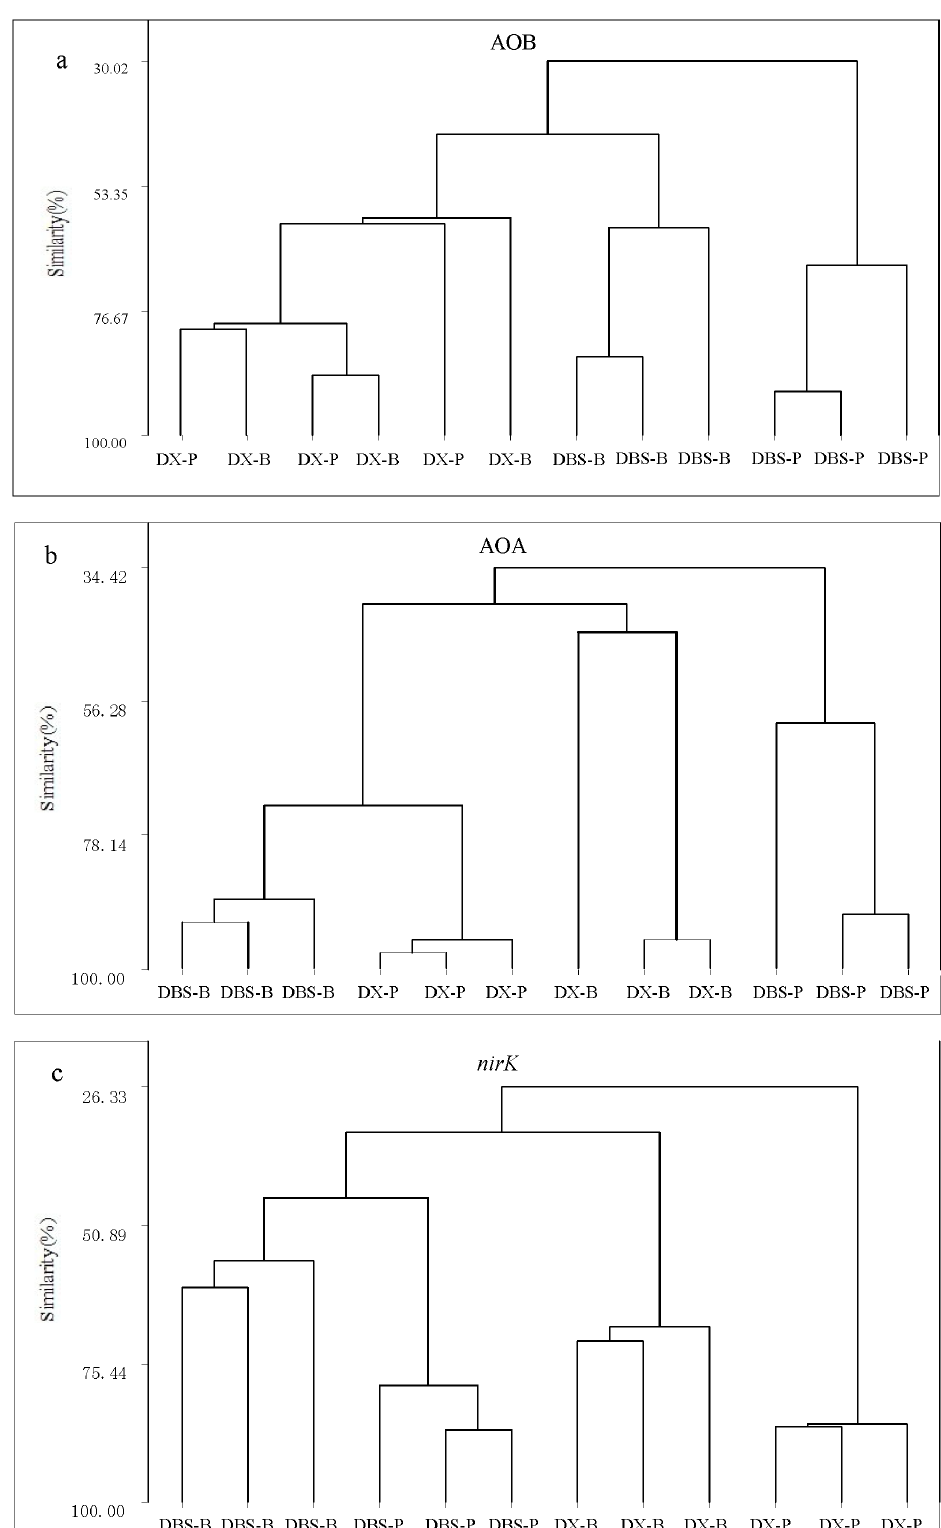
Figure 1. The cluster analysis of DGGE profiles of AOB (a), AOA (b) and nirK (c) gene fragments from the soil samples at the two sites. DX-B and DBS-B, background soil from site DX and DBS; DX-P and DBS-P, polluted soil from site DX and DBS. Euclidean distances were calculated from relative positions and intensities of bands, and the samples were clustered using Pearson’s product-moment coefficient and a UPGMA (Unweighted Pair Group Methods with Arithmetic mean) algorithm.